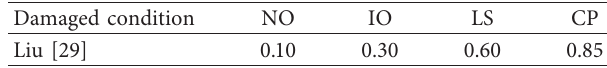
Table 1: The threshold of damage factors of different performance